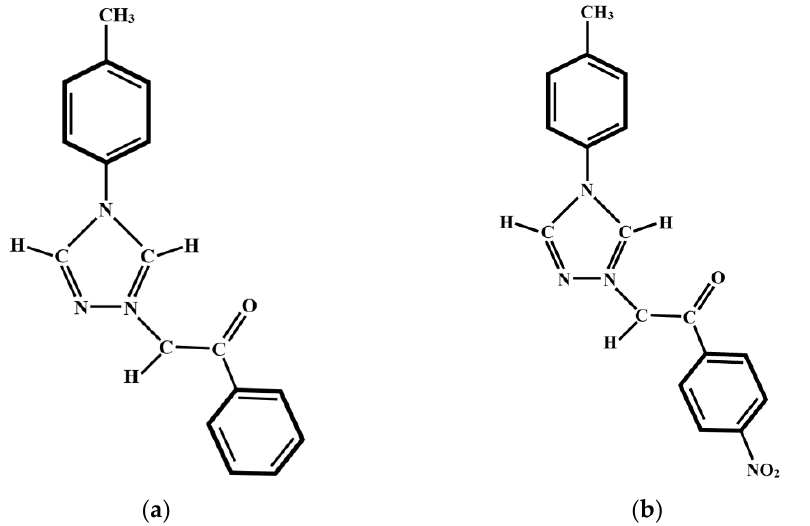
Figure 1. Chemical structure of 4-tolyl-1,2,4-triazol-1-ium phenacylid (TTPY) ( a ) and 4-tolyl-1,2,4- triazol-1-ium-4 ’ -nitro-phenacylid (TTNPY) ( b ) molecules.